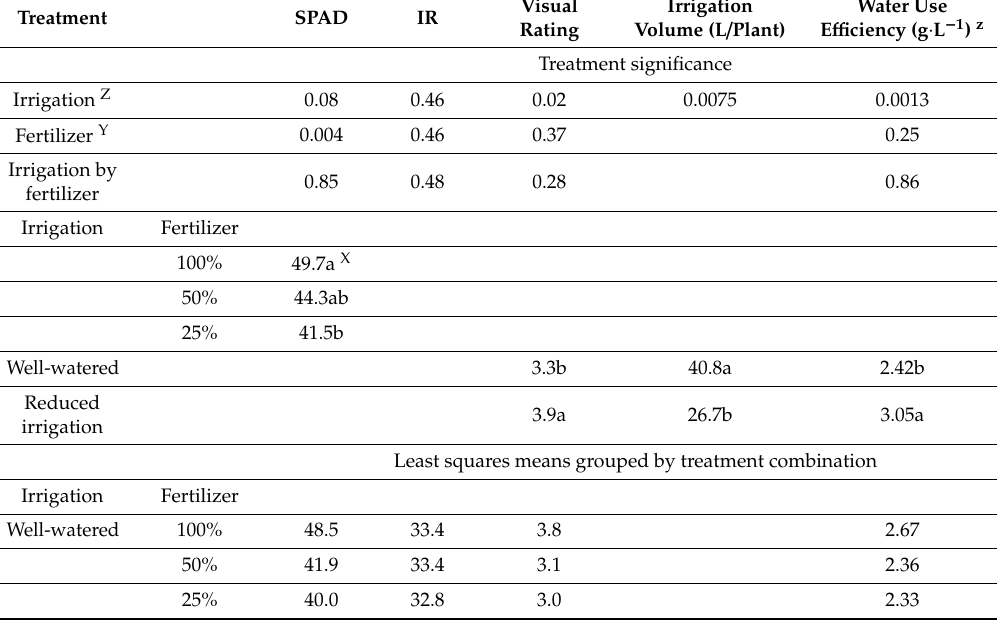
Table 3. Leaf greenness [Special Products Analysis Division (SPAD)], IR temperature, visual rating, total irrigation volume, and water use e ffi ciency of beardtongue at the conclusion of the 73 d experiment. Well-watered irrigation treatments were maintained at a volumetric water content (VWC) of 40% and reduced irrigation treatments were maintained at a VWC of